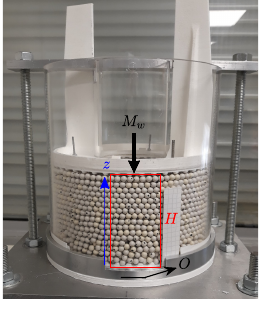
Figure 1. Experiment setup for annular shear cell containing marked spheres. Various loadings M w are imposed on top wall while the bottom plate rotating at di ff erent rates O